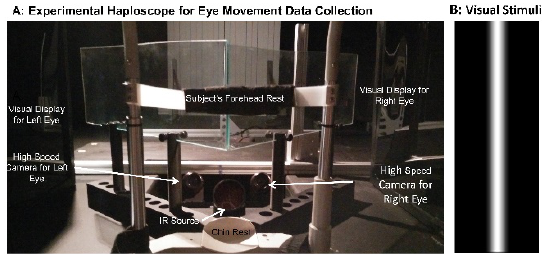
Figure 1A: Experimental set-up of haploscope used to record disparity vergence eye movements. Figure 1B: ‘Difference of Gaussian’ (DoG) stimulus used for all vergence and saccadic